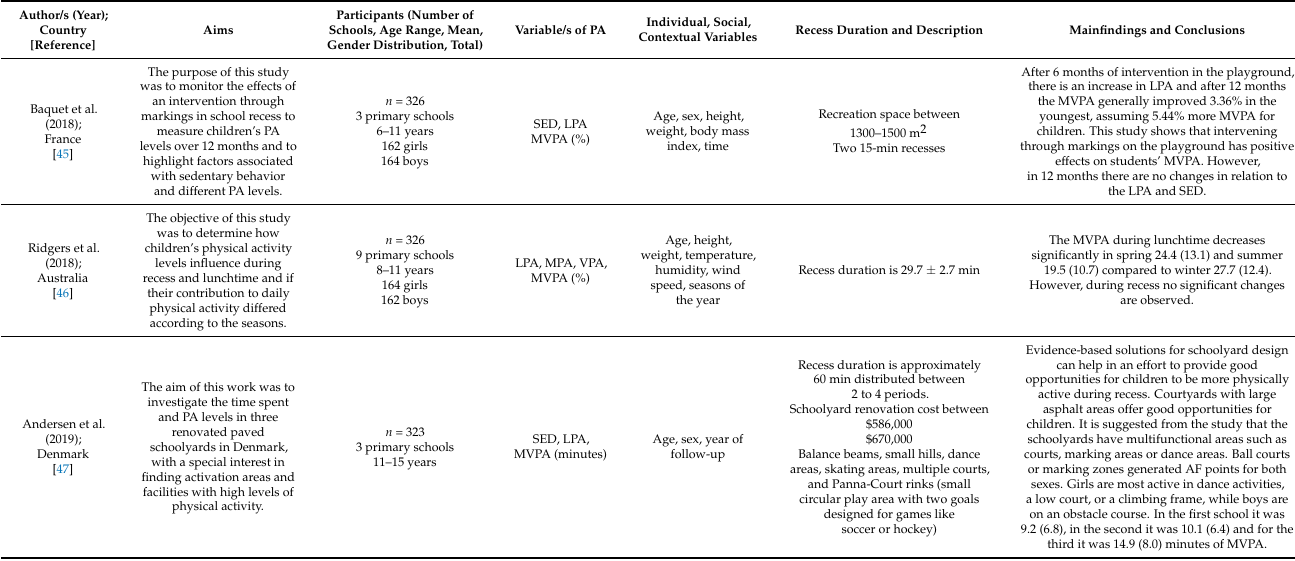
Table 4. Main characteristics of longitudinal